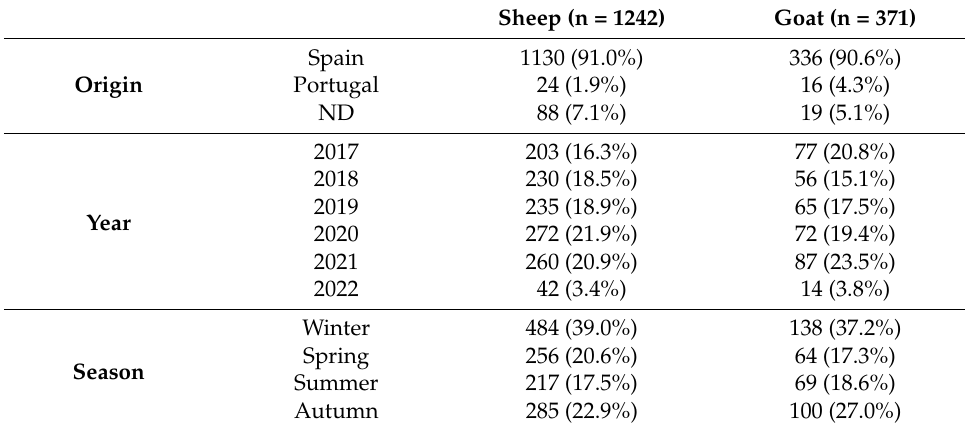
Table 1. Distribution of the ovine and caprine abortion cases studied according to the country of origin, year and season. Data are counts (%). ND: not